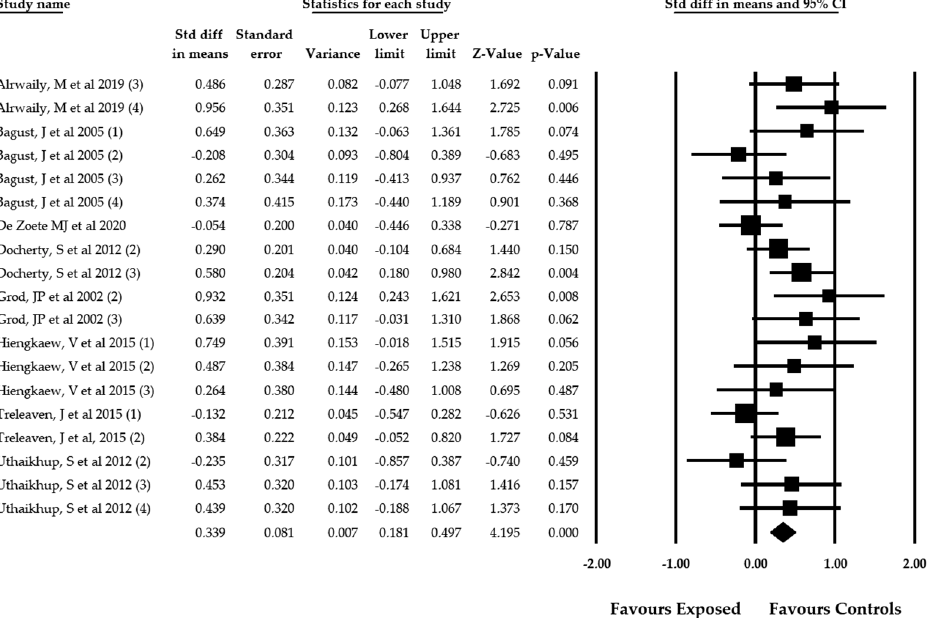
Figure 3. Forest plot for the perception of the visual verticality assessed with the RFT in patients with spinal pain (effect sizes are expressed as standardized mean difference).